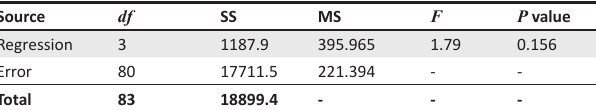
TABLE 3: Analysis of variance for the mean time between failures and the mean time between maintenance.